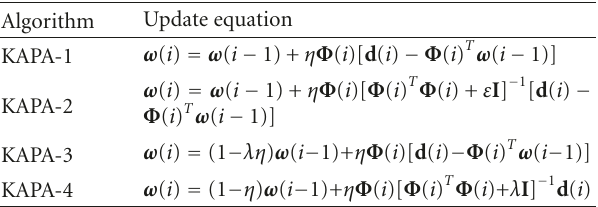
Table 2: Comparison of four KAPA update